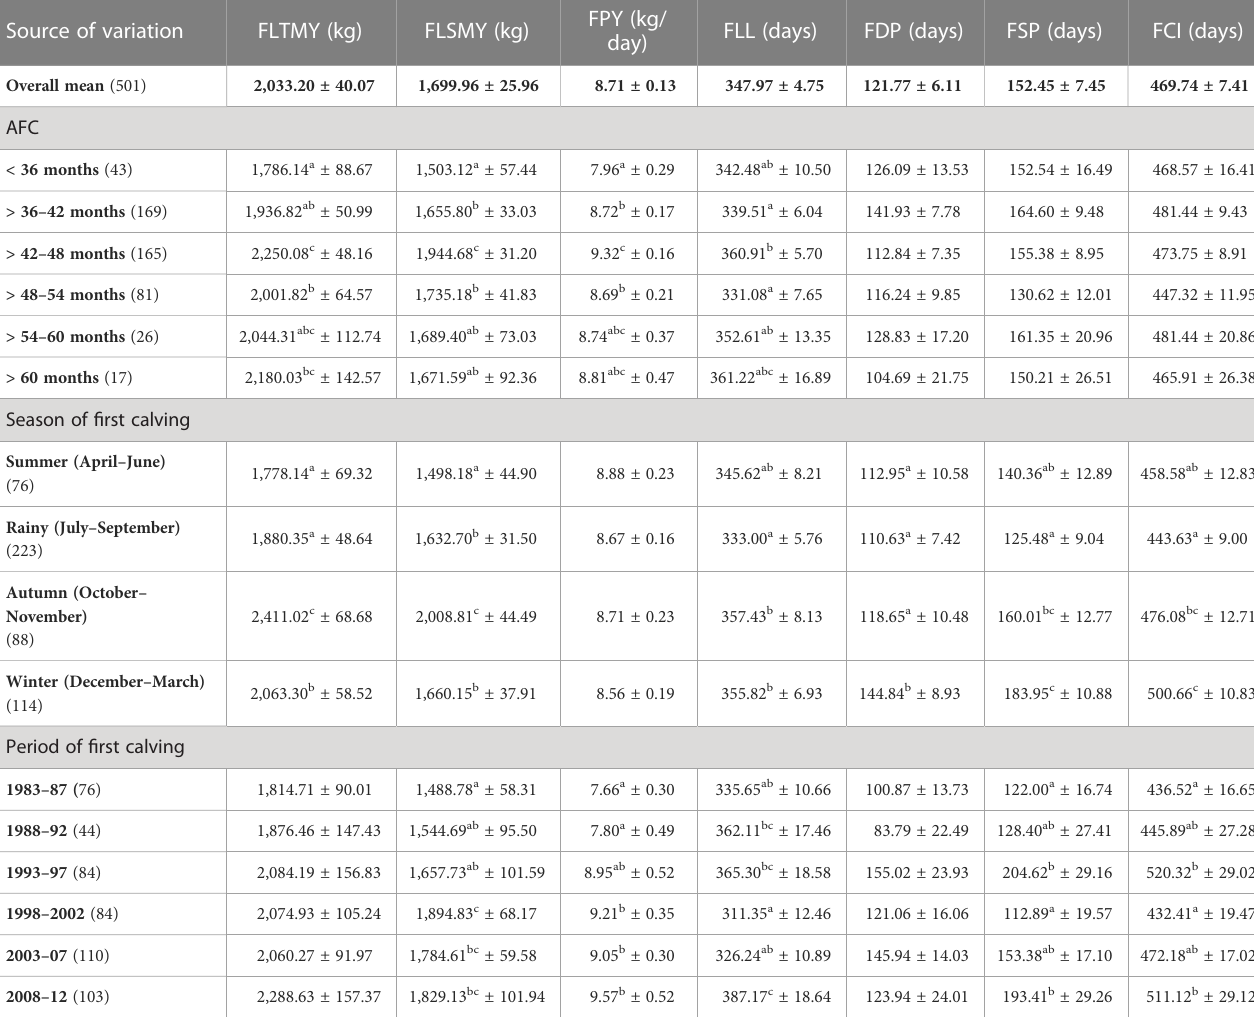
Means bearing different superscripts in a column differ signi fi